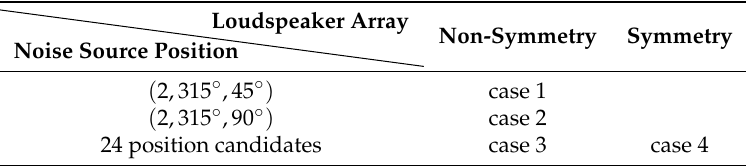
Table 1. Loudspeaker array setup and noise source location in 4 cases, which are given in Figures 2 and 5, respectively.